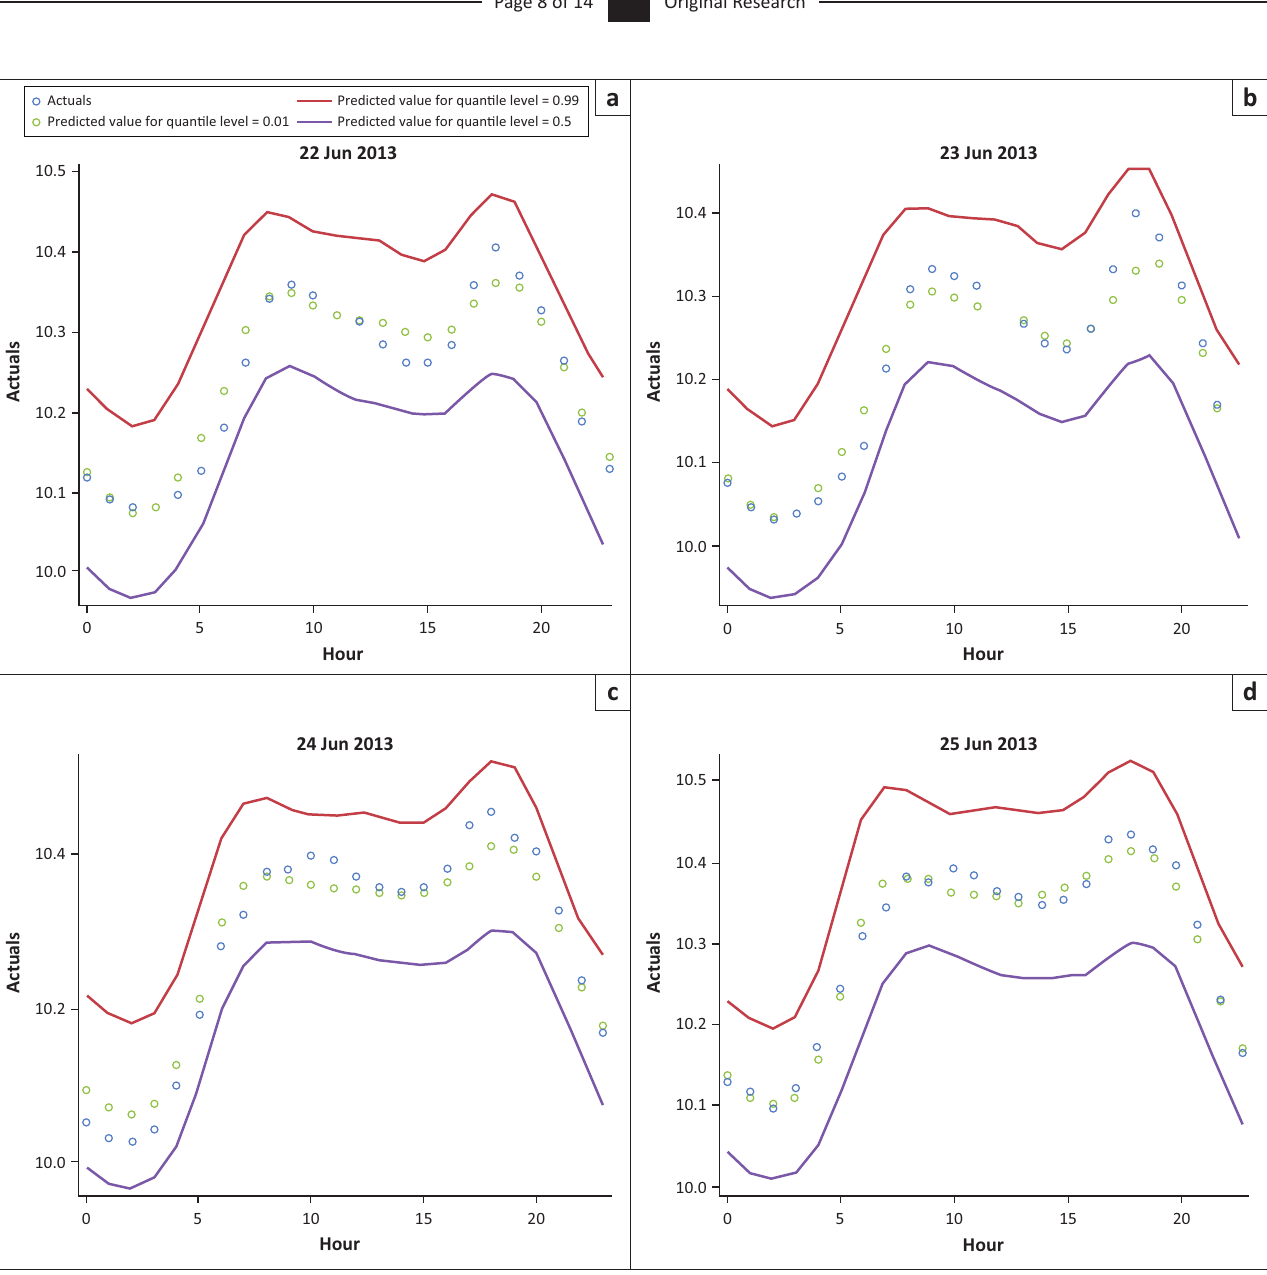
FIGURE 4: Distribution of forecasted daily electricity demand: (a) 22 June 2013, (b) 23 June 2013, (c) 24 June 2013, (d) 25 June